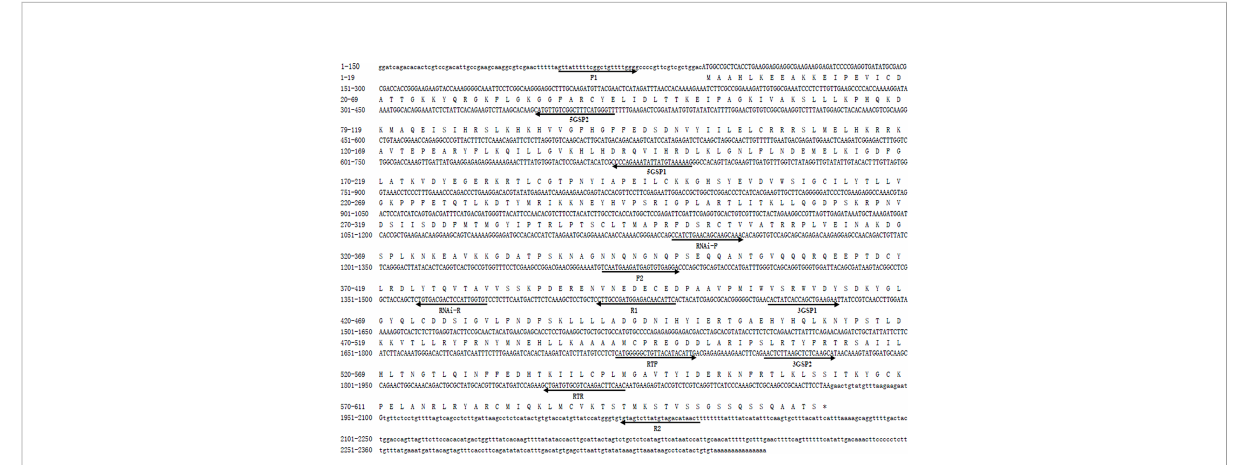
FIGURE 1 Nucleotide and deduced amino acid sequence of Mn-Plk1 . The nucleotide sequence is displayed in the 5 ′ – 3 ′ directions and numbered at the left. The deduced amino acid sequence is shown in a single capital letter amino acid code. Arrows indicated the location and direction of each primer. 3 ′ UTR and 5 ′ UTR are shown with lowercase letters. Codons are numbered at the left with the methionine (ATG) initiation codon, an asterisk denotes the termination codon